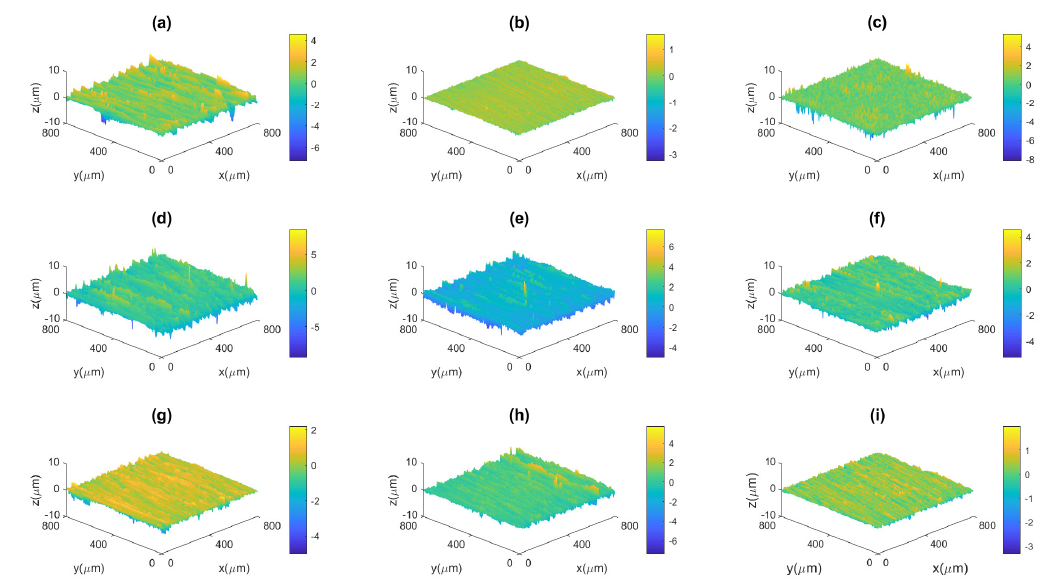
Figure 3. Surface morphologies of brass samples, the samples polished by using grit densities of 180, 320, 400, 600, 800, 1000, 1200, 1500 and 2000, were denoted from ( a – i ),